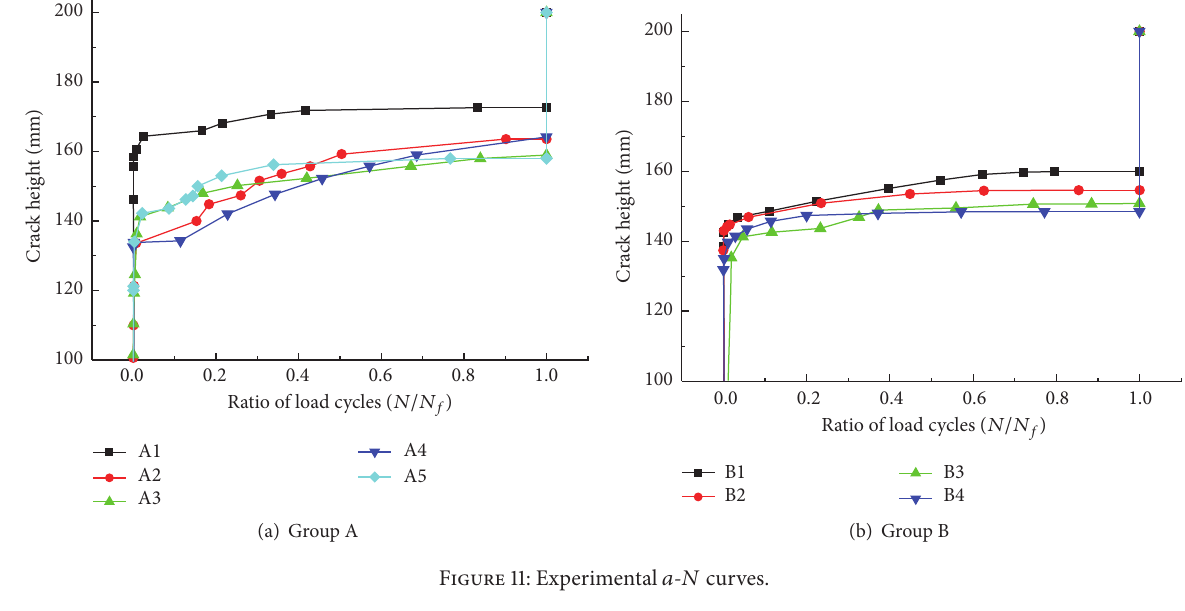
Figure 11: Experimental 𝑎 - 𝑁 curves.